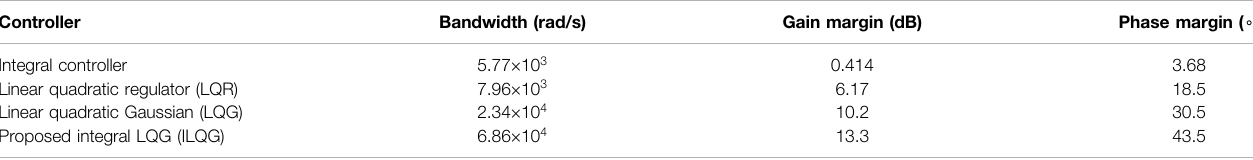
TABLE 4 | Comparison of bandwidth, gain margin and phase margin using different